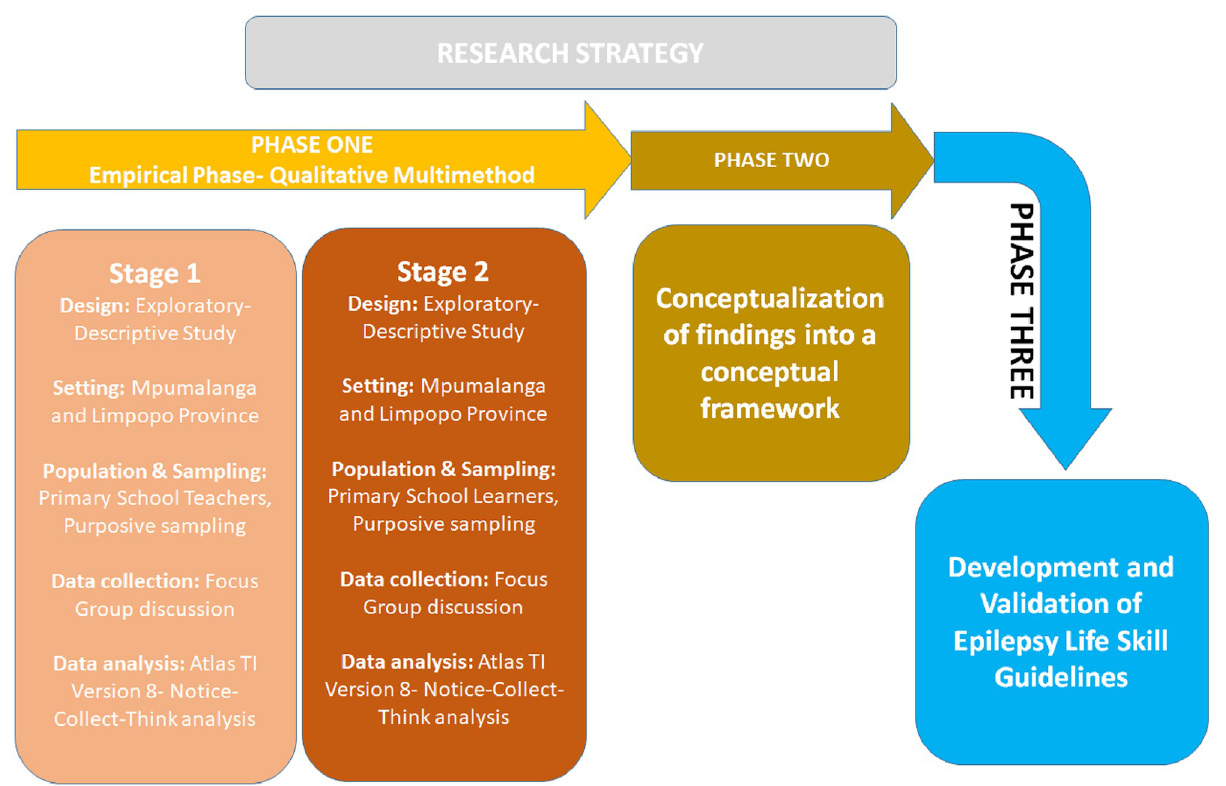
Fig 2. Illustration of the Study’s research